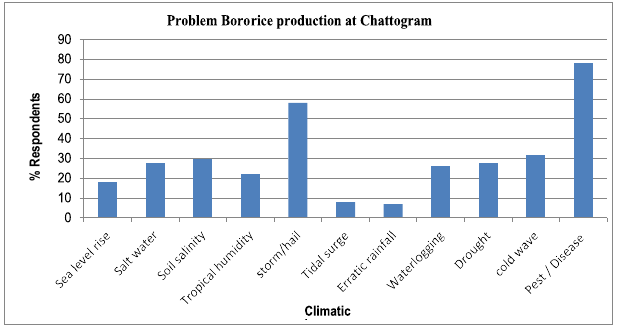
Figure 10: Farmers response on impacts of climate change on Boro rice